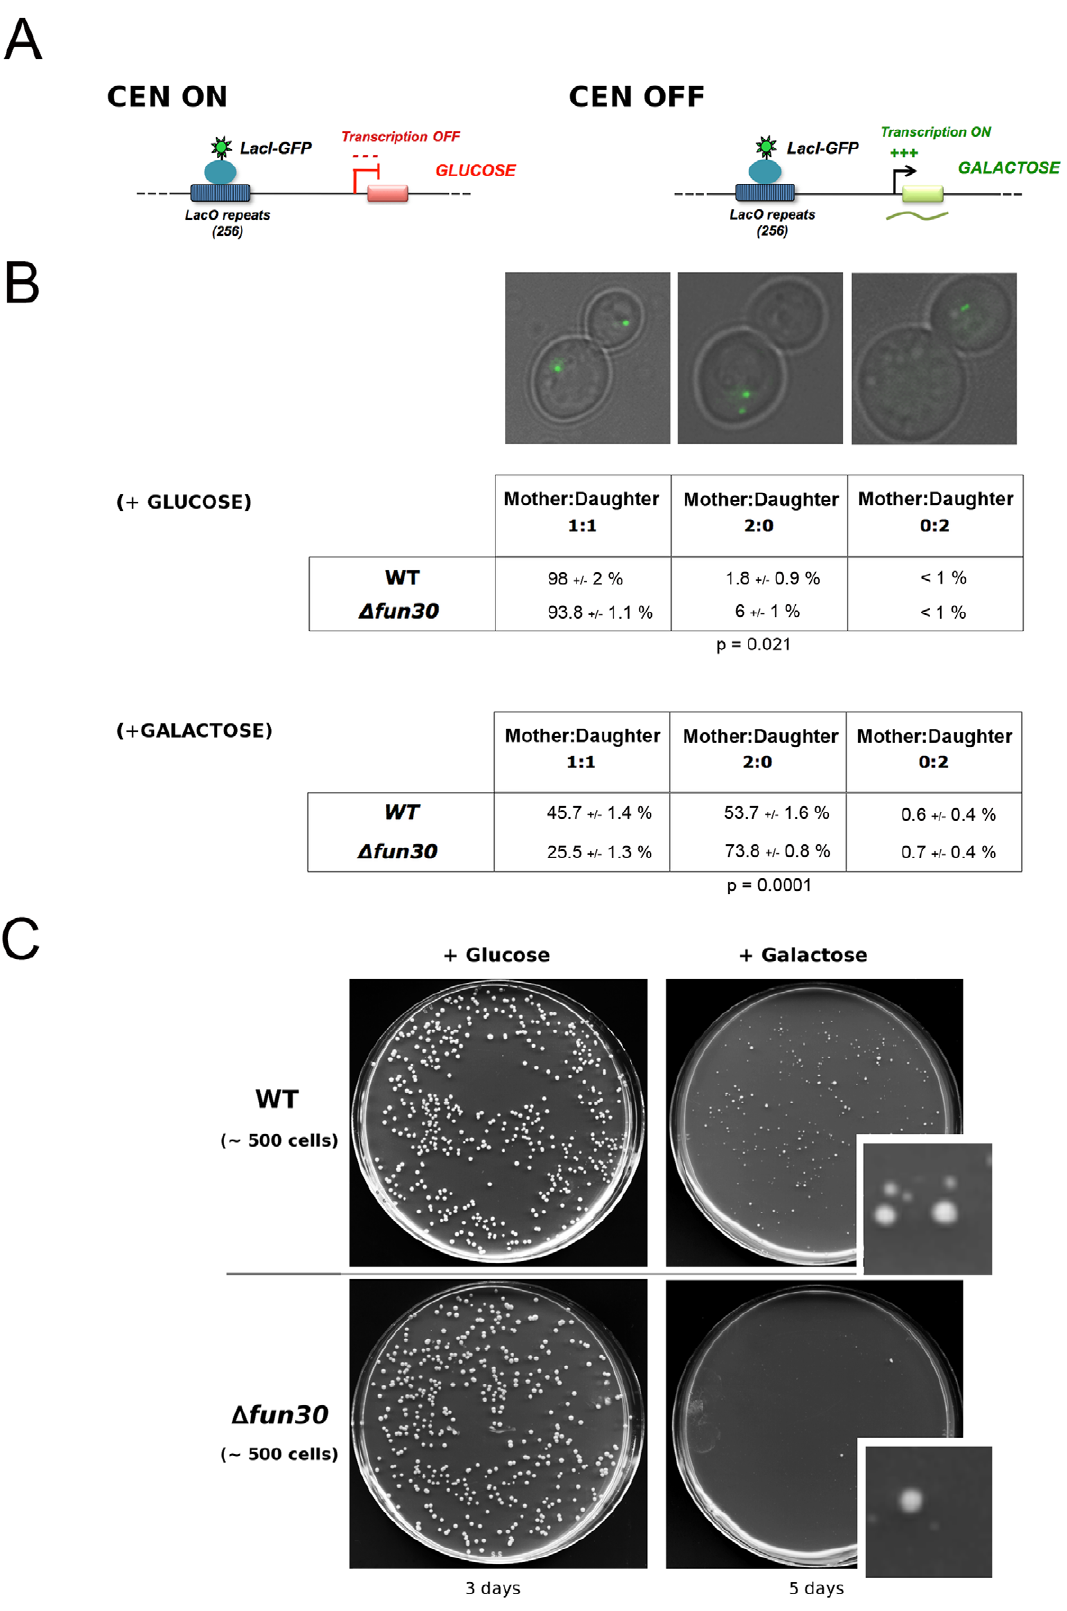
Figure 4. Absence of Fun30 increases chromosome segregation defects upon transcription through a centromere. A) Schematic depiction of the transcription-regulated centromere system. In the presence of glucose transcription through centromere III is repressed and the centromere functions normally (left panel). Galactose induces transcription that perturbs centromere function (right panel). Chromosome